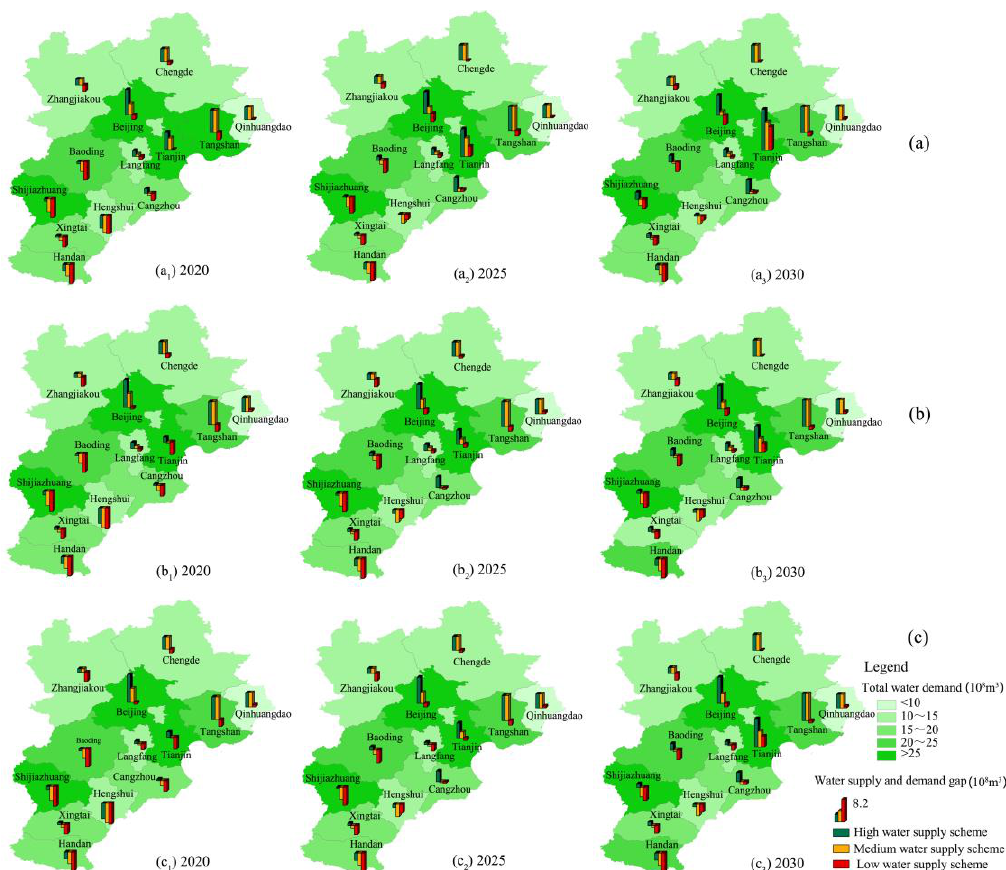
Figure 6. Water supply and demand gap in water-consuming mode under different urbanization development scenarios in BTH urban agglomeration. ( a ) Core development mode. ( b ) Subcore development mode. ( c ) Multinode development mode.